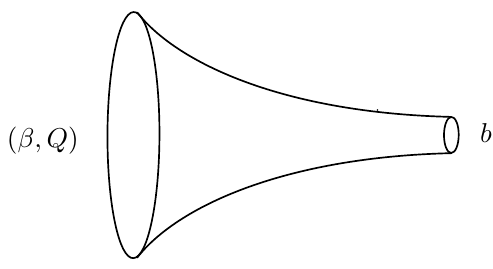
Figure 2 . The trumpet geometry: we specify the boundary conditions β and Q at the end of the asymptotic boundary. The small end is labeled by the length b of the geodesic